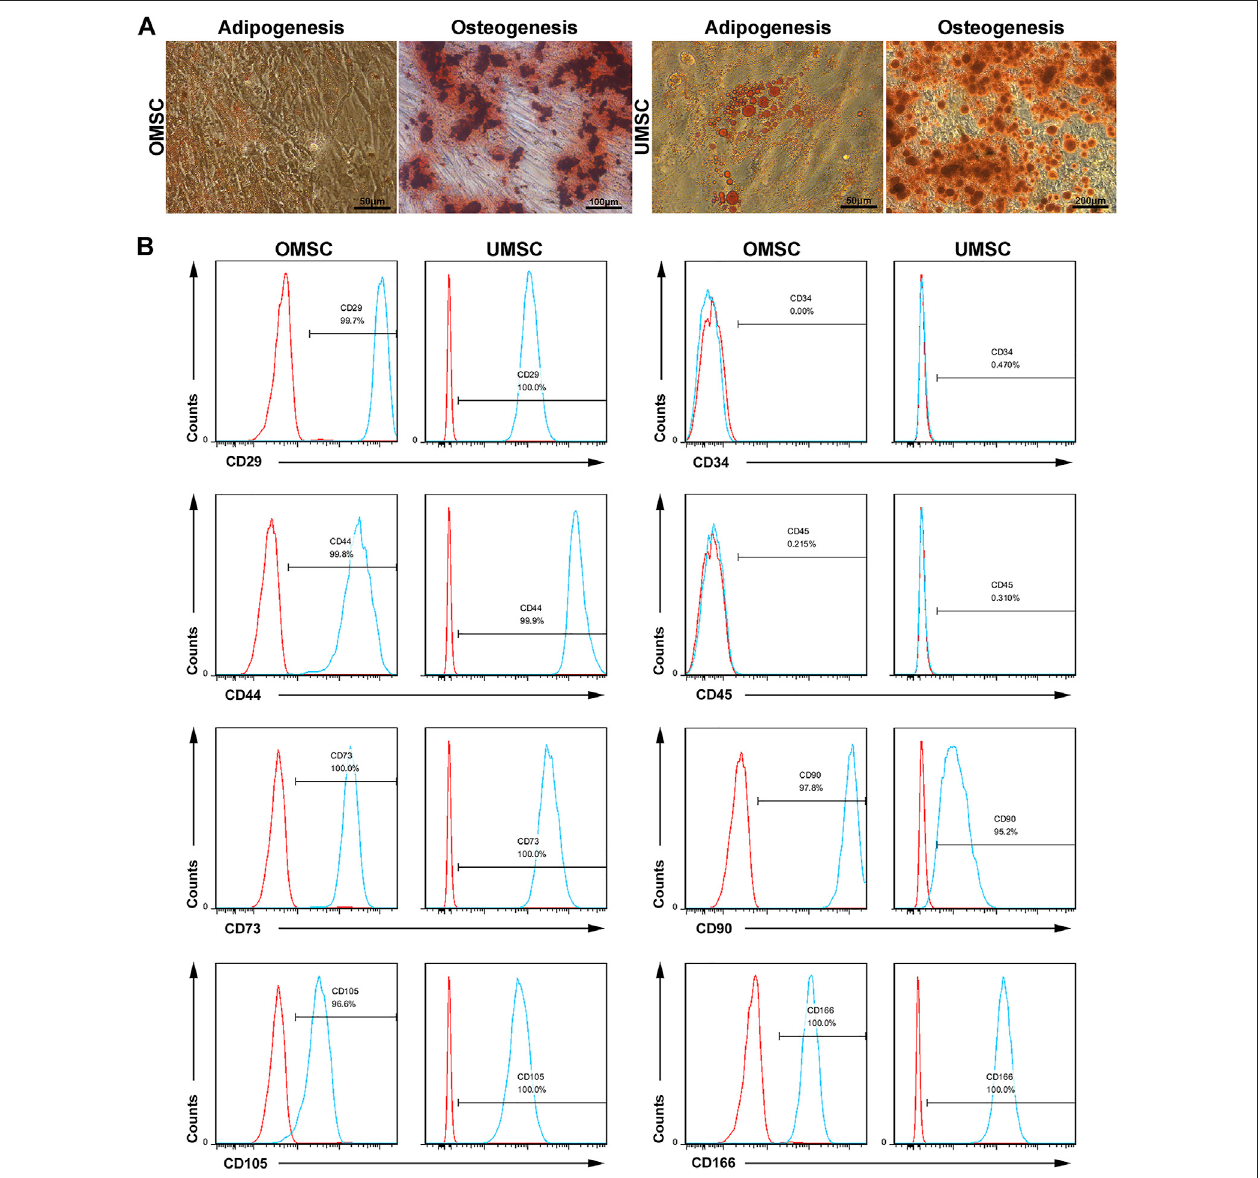
FIGURE 1| Differentiation potential and phenotypes of the OMSC and UMSC: (A) MSCscaptured by the microscope. Alizarin Red S chelates with calcium ions to form a red or purplish red complex, which represents the osteogenic formation of OMSC and UMSC. Oil Red O colorizes the lipid inside the MSCs and appears as red lipid droplets, which represents adipogenic formationof OMSCand UMSC. (B) Phenotypes ofOMSC, including CD29, CD34,CD45,CD44, CD73, CD90, CD105,and CD166, were detected by fl ow cytometry.